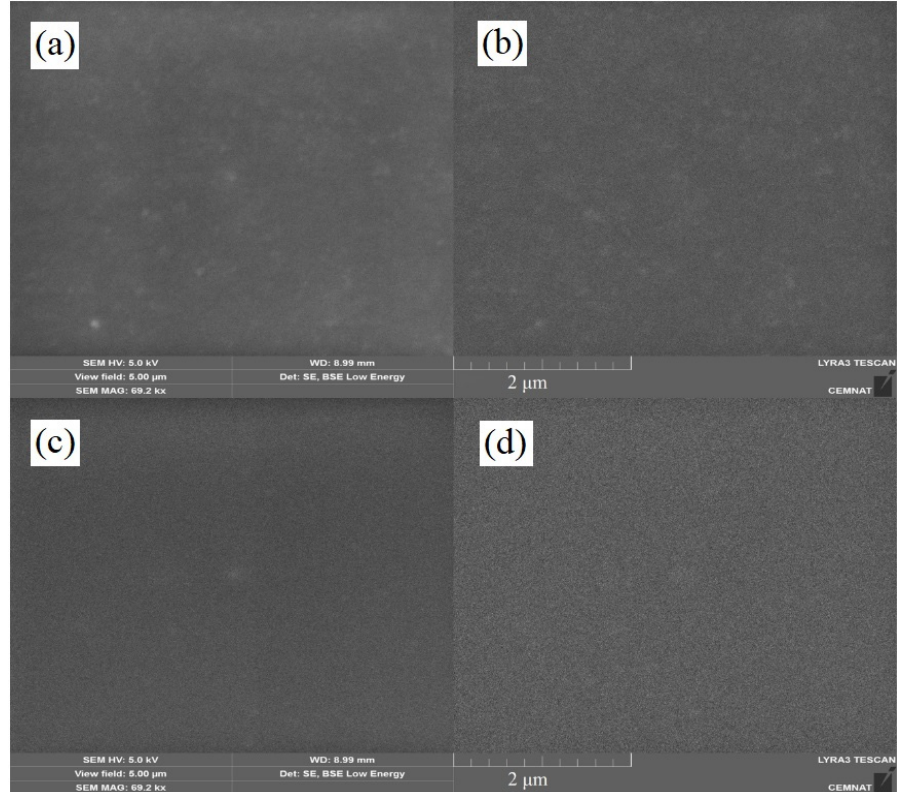
Figure 2. The SEM images of the surface of the cryo-fractured coating film sample LM ( a , b ) and L0 ( c , d ) taken in secondary ( a , c ) and backscattered electrons ( b , d ). Table 6. Evaluation of coating films of self-crosslinking latexes (DFT = 50 ± 10 µ m).